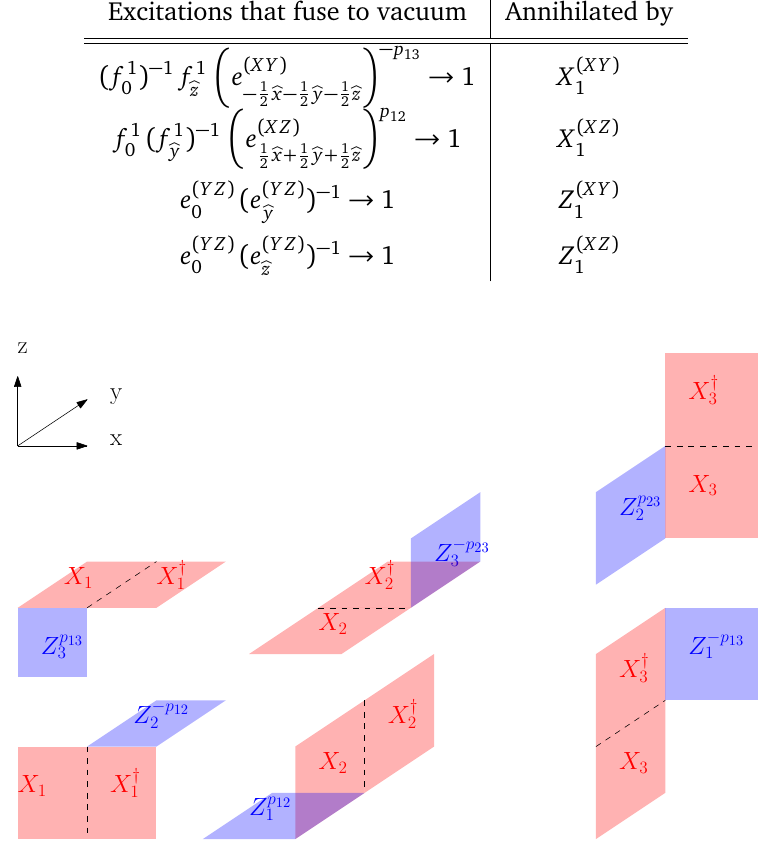
Table 2: Excitations of Figure 3 that can be fused to the vacuum. We only list the excitations annihilated by acting with X symmetry (3.22). In the second column, X plaquette, and similar for the other operators.